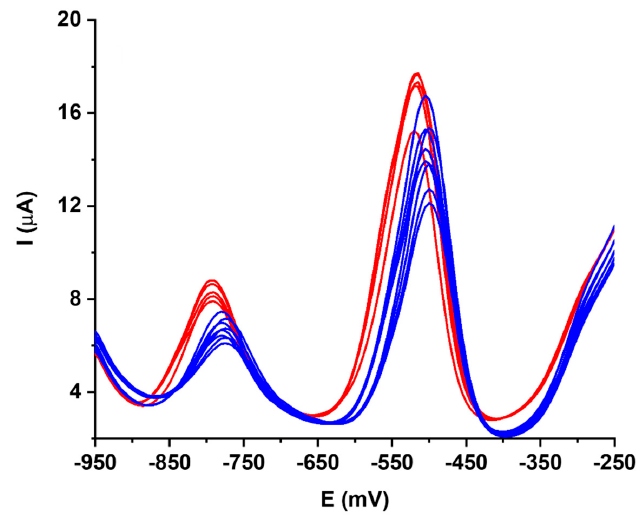
Figure 3. Effect of nitrate addition (blue trace) on Pb and Cd analysis in HCl at pH = 2 (red trace) on a working Bi/PO 4 /PSS electrode.